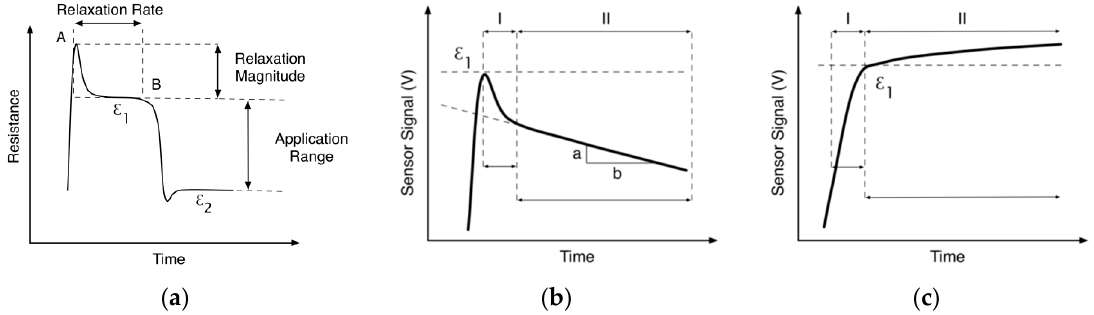
Figure 7. General behavior of the conductive polymer when a new strain level is applied ( a ); where an abrubt peak is seen, followed by a relaxation, a near-linear signal degradation is seen ( b ); In a slighlty under-loaded state ( c ) the signal gradually rises, attributed to the visoelastic nature of the integration materials.